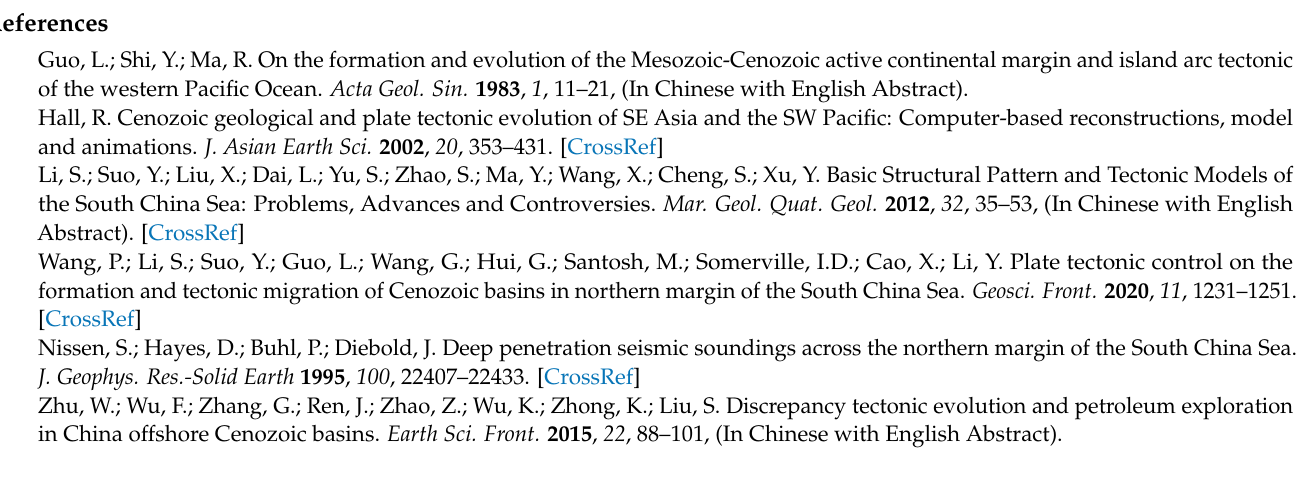
Figure S2: (a) The heat flow from observation and inversion along profile L1 are represented by red and blue points, respectively. The ratio between crustal heat flow and mantle heat flow is indicated by yellow points. Q c , crustal heat flow; Q m , mantle heat flow. (b) Thermal structure calculated from the simulation of profile